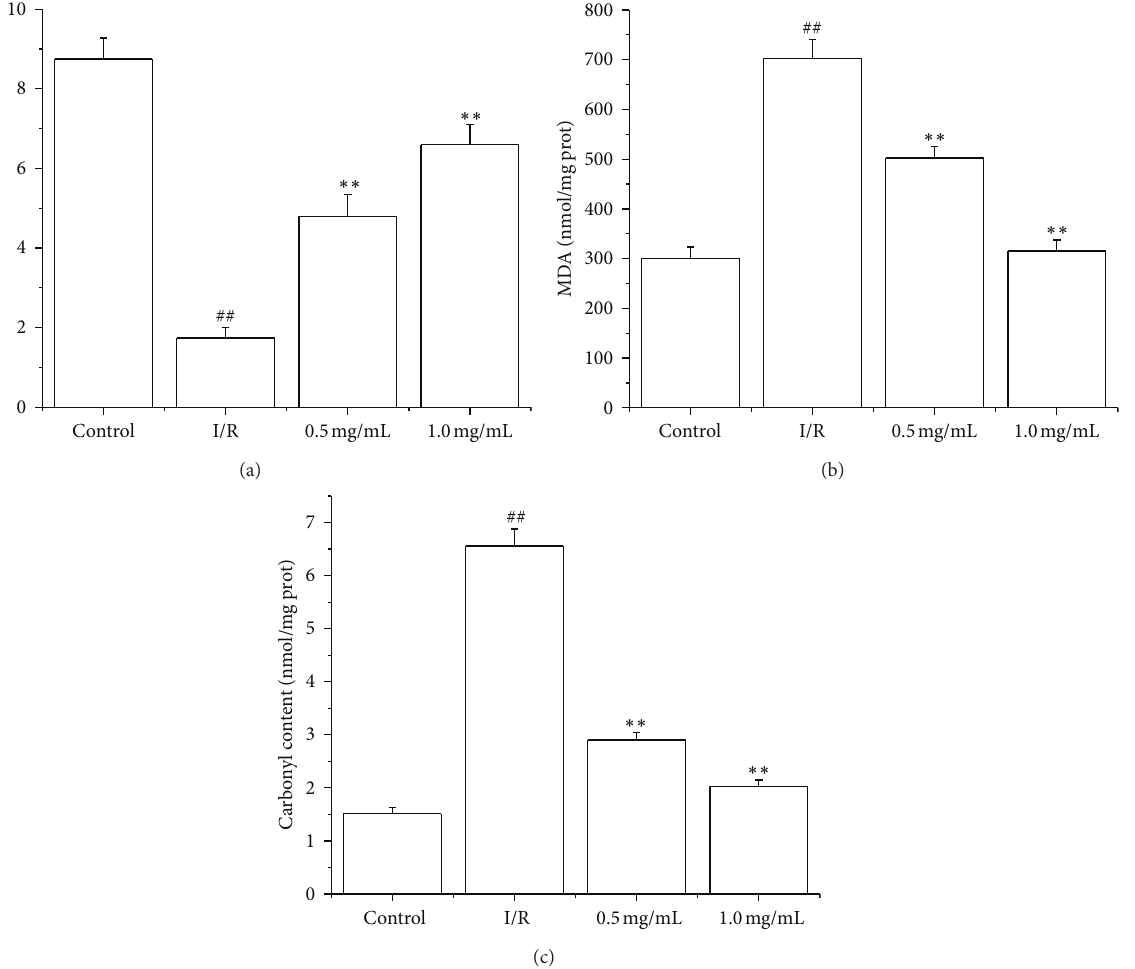
Figure 3: Effects of EA on SOD activity (a), MDA level (b), and carbonyl content level (c). Values are means with their standard deviation ( 𝑛 = 8 ); ## 𝑃 < 0.01 compared with control group; ∗∗ 𝑃 < 0.01 compared with I/R